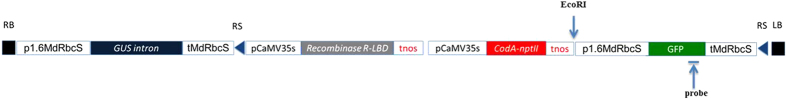
T-DNA organization of the binary plasmid used, pJS-M14.RB is right border; LB is left border; there are two recombination-sites (RS), and in between them there are 3 genes (combinations), i.e. Recombinase R-LBD, codA-nptII and gfp. Outside the RS sites there is the marker gene gusintron, acting as gene-of-interest. The gusintron and gfp were both driven by apple 1.6 kb Rubisco promoter and apple Rubisco terminator (Schaart et al., 2011). After recombination, the genes between the RS sites will be removed, while the gusintrongene will remain. The unique restriction site EcoRI is used for digestion prior to Southern blotting; thegfp gene is the target for probing.